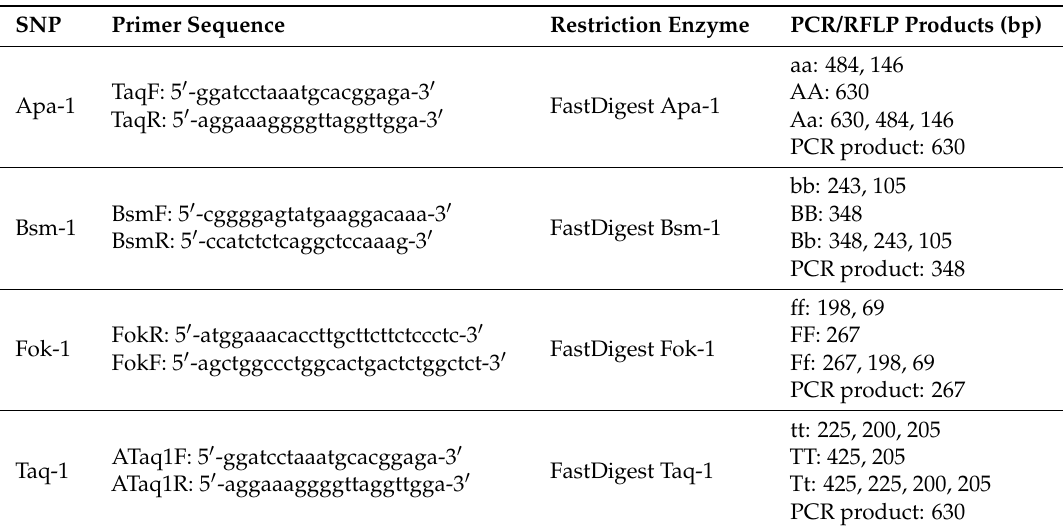
Table 4. Primers for VDR SNPs and polymerase chain reaction-restriction fragment length polymorphism (PCR-RFLP)